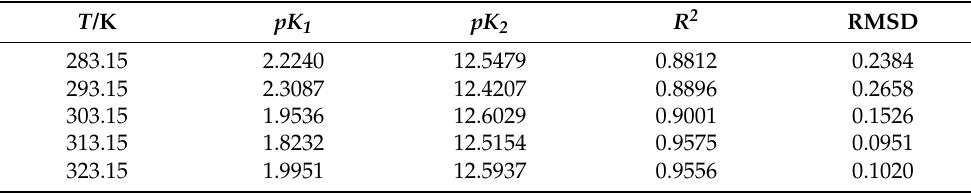
Table 7. Nezhad equation fitting parameters for the solubility of phenylglycine in water affected by